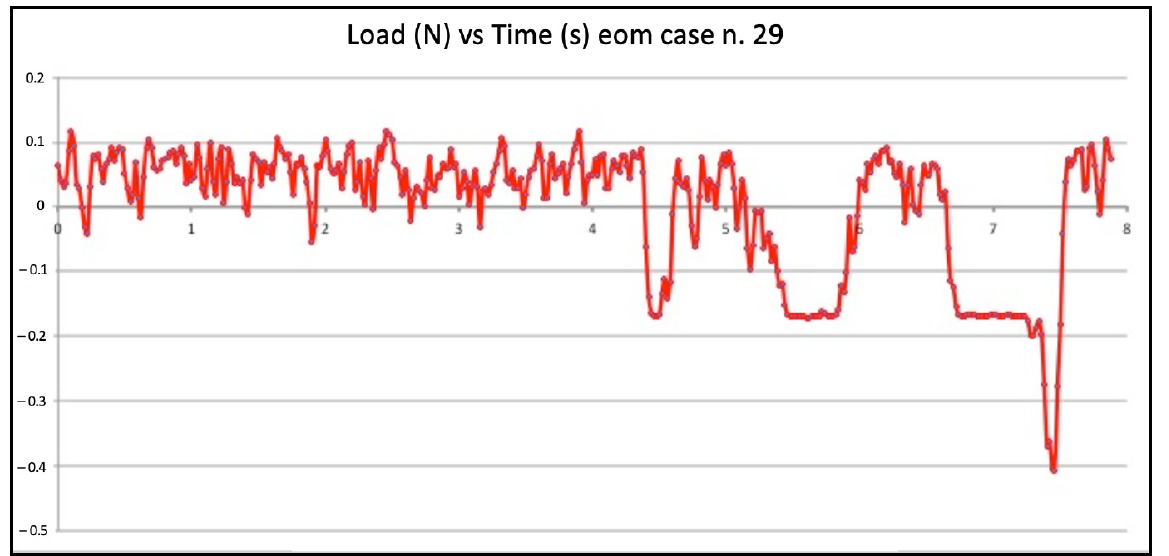
Figure 9. Graphic plot of the simulation on model n. 29 (failed envelope of motion negotiation).